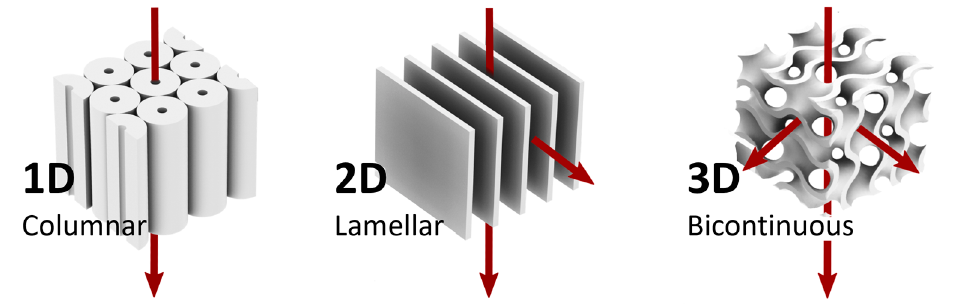
Figure 2 . Nanoporous liquid crystal networks having various morphologies. Columnar and hexagonal yield 1D pores, lamellar or smectic mesophases yield 2D pores, and bicontinuous mesophases give a 3D pore geometry.